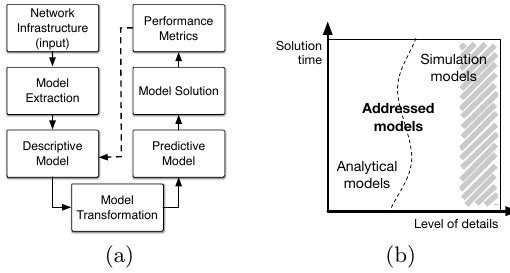
Figure 1: (a) Process of performance prediction based on model-to-model transformations. (b) Ab- stract division of prediction models into analytical and simulation models. Models with very fine mod- eling granularity (gray area) are not our target.